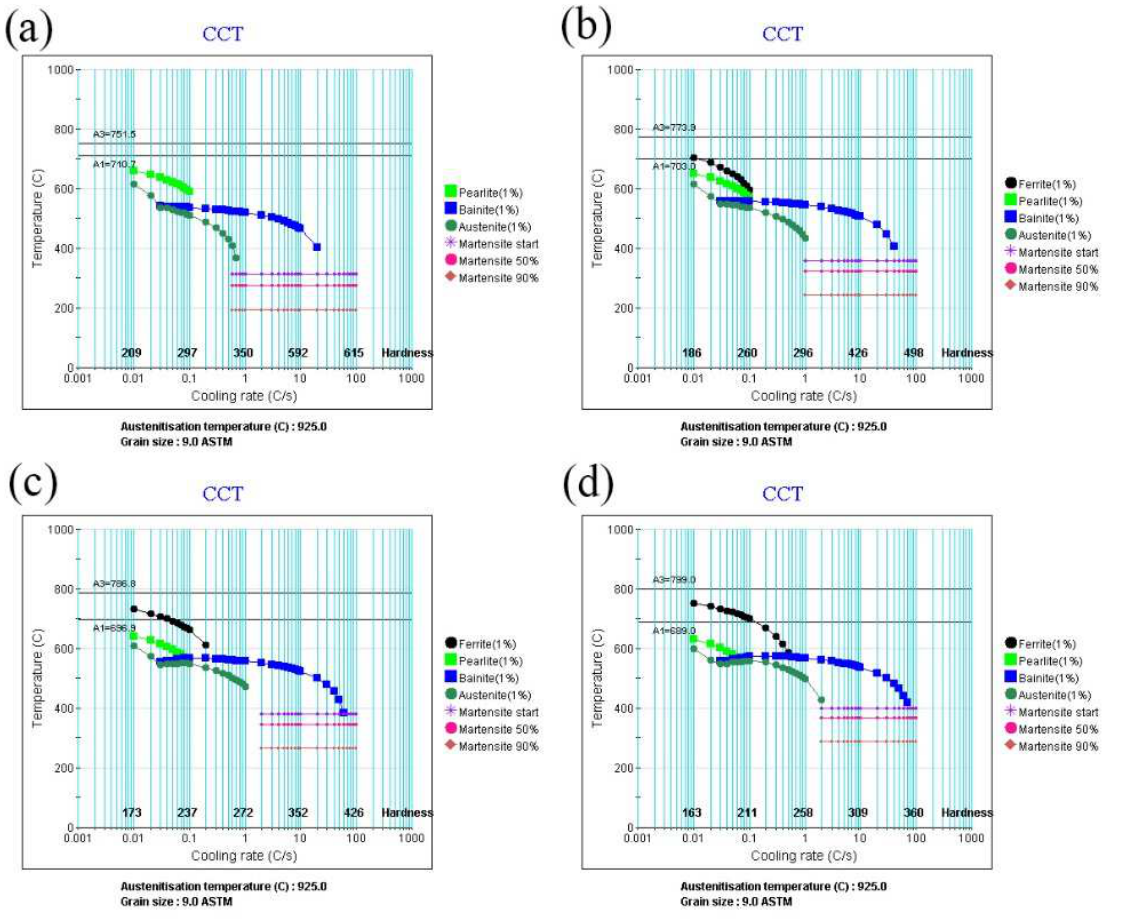
Figure 9. CCT simulation curves of different carbon contents SXQ500/550DZ35: ( a ) carbon content 0.348%, ( b ) carbon content 0.225%, ( c ) carbon content 0.163%, and ( d ) carbon content 0.110%.